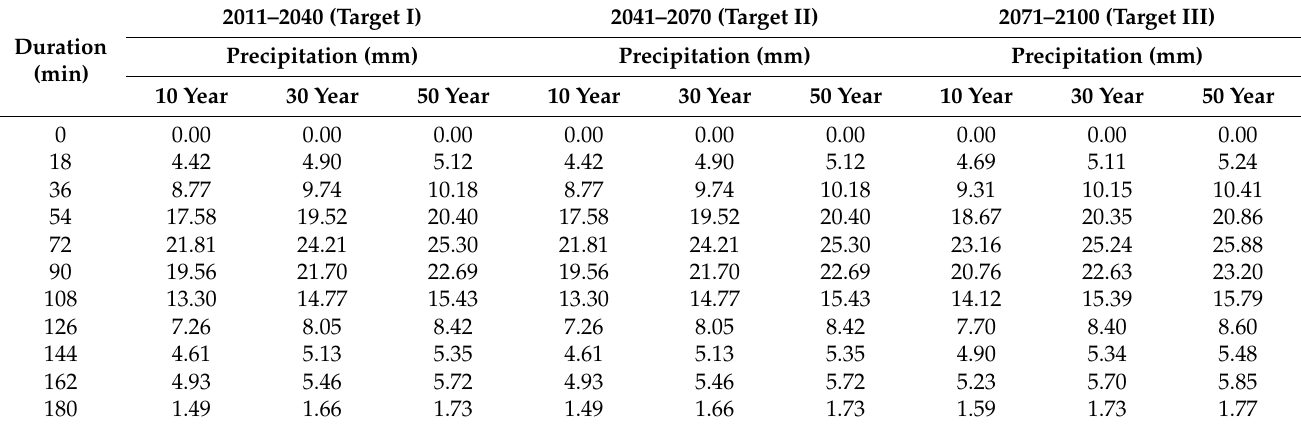
Table 4. Predicted probable precipitation for three target periods for the duration of 3 h in Changwon City [47].